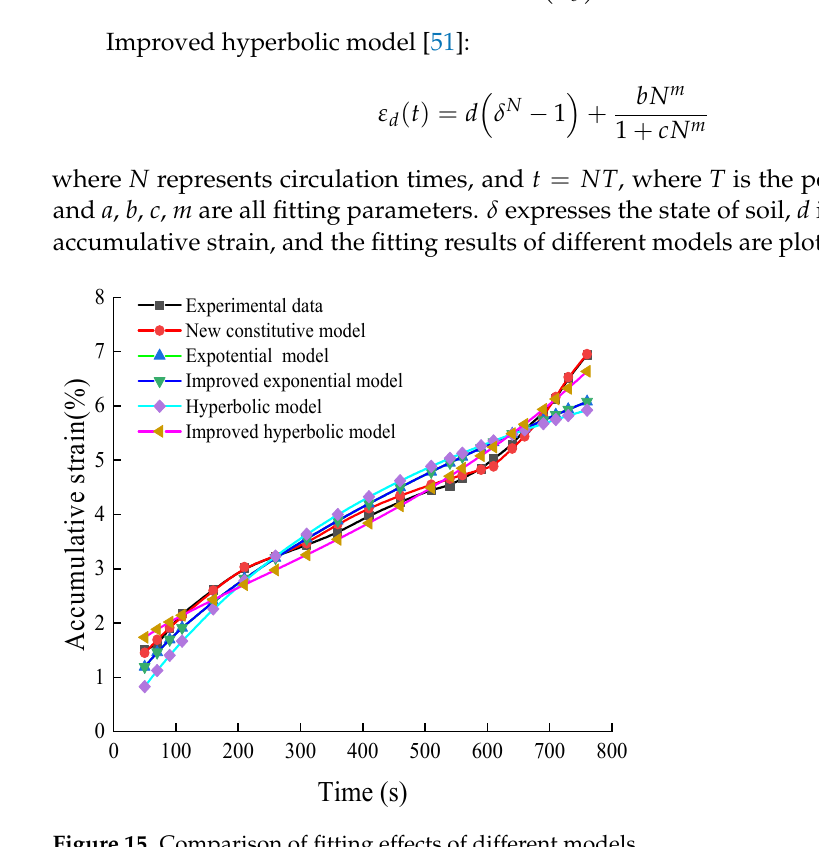
Figure 15. Comparison of fitting effects of different models.